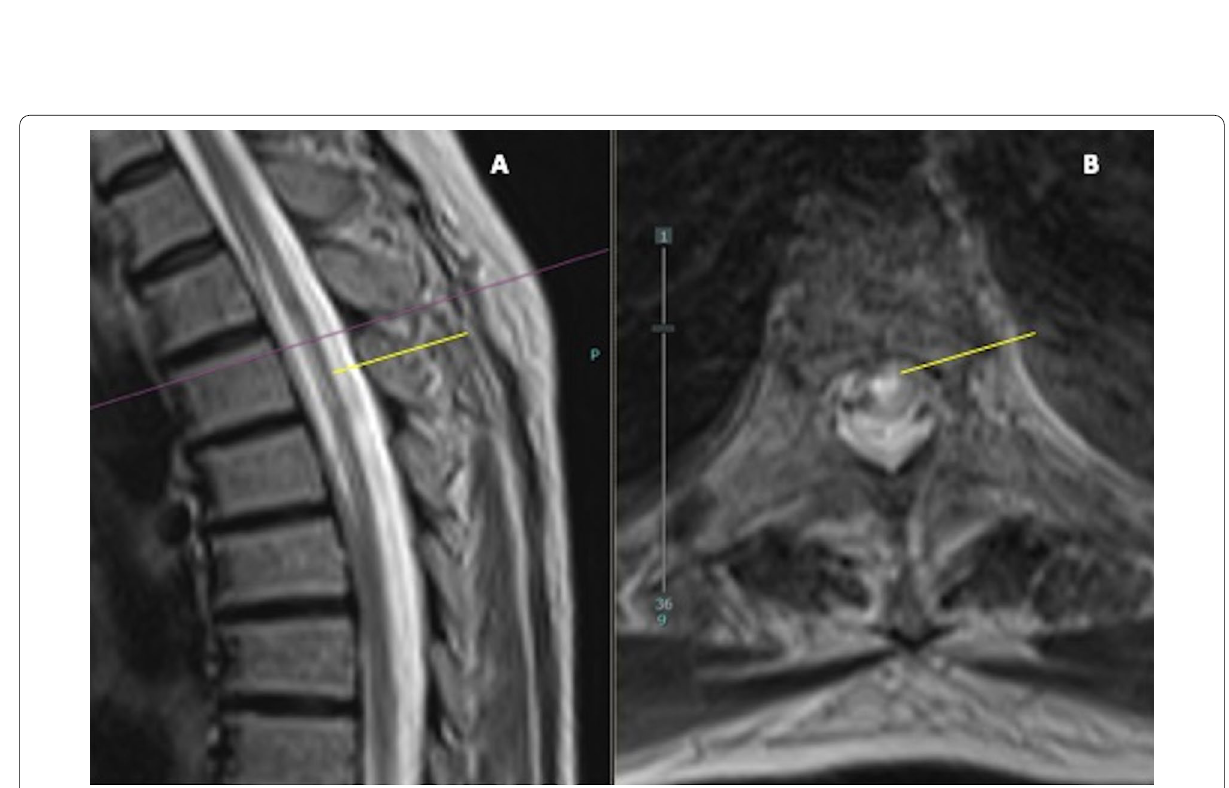
Fig. 4 MRI sagittal T2 image ( A ) of the cervical spine demonstrates longitudinally extensive T2 hyperintense cord lesions (yellow arrow), with corresponding foci that are as bright or brighter than CSF on the axial images ( B ) (yellow arrow)